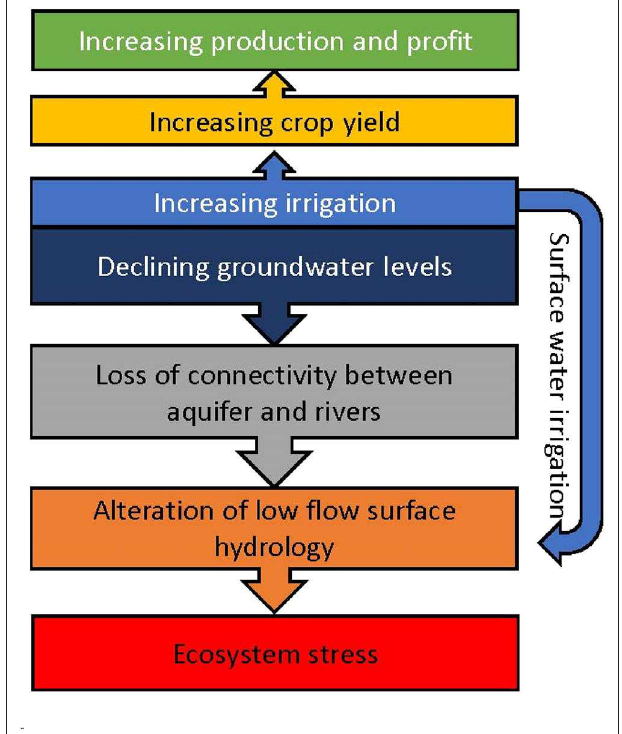
FIGURE 1 | Conceptual diagram outlining the hypothesized costs and benefits of increasing irrigation in the Mississippi Alluvial Plain. The ultimate benefit is increased production and profit, while the ultimate cost is ecosystem stress. This study focuses on the aspects from crop yield to alteration of low flow